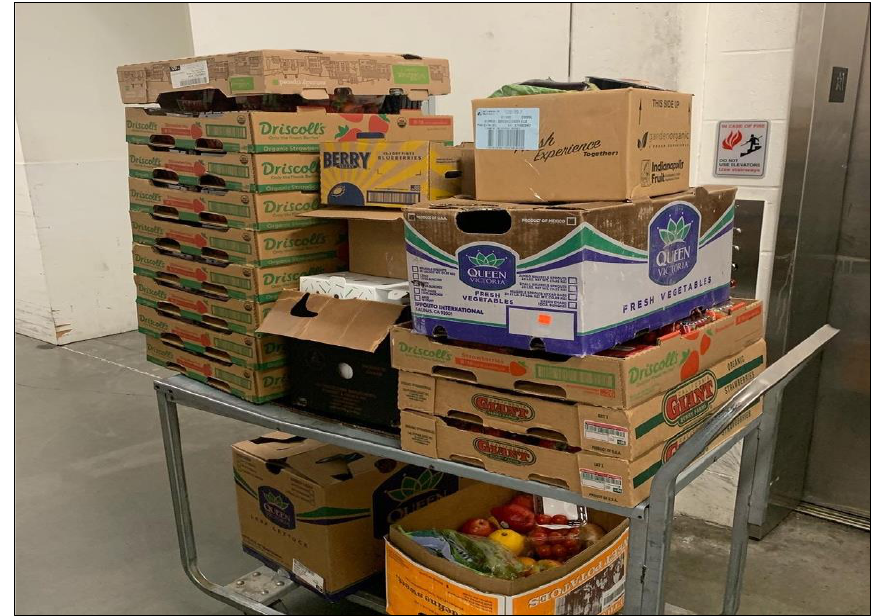
Figure 2. Boxes Filled with Produce from a Daily Recovery Photo courtesy of Campus Food